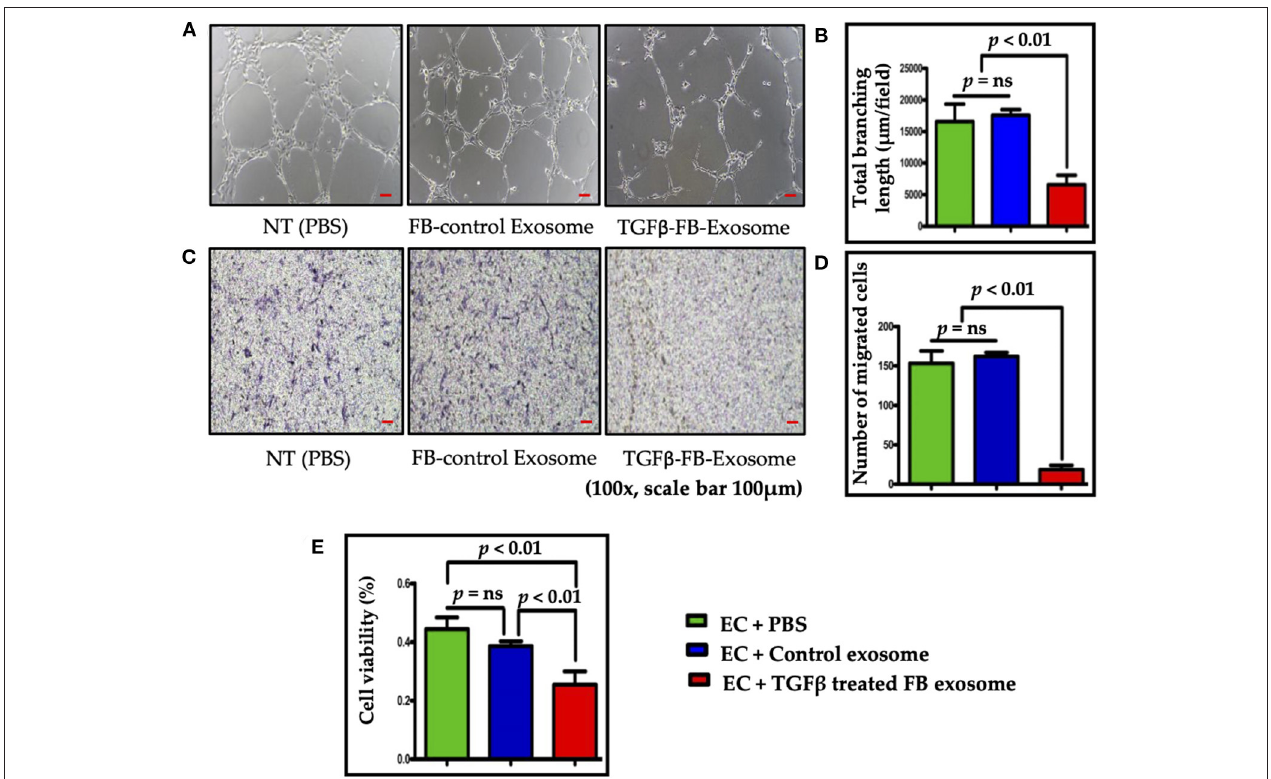
FIGURE 3 | Exosomes derived from TGF β -activated fibroblast reduced endothelial cell function and viability. (A,B) Tube formation assay for endothelial cell angiogenesis function; representative images are shown. For data analysis the length of branch points was measured using NIH ImageJ software, and the mean length is represented in the graph. Activated FB-derived exosome treatment significantly impaired tubulogenic potential of heart ECs. (C,D) Images of ECs with Giemsa stain for evaluating cell migration in a Boyden chamber. As anticipated, activated FB-derived exosomes significantly reduced EC migration as compared to control. (E) MTT assay to measure endothelial cell viability. Endothelial cell viability (%) was significantly reduced after treatment with activated FB-derived exosomes. P < 0.05 was considered as statistical significance.